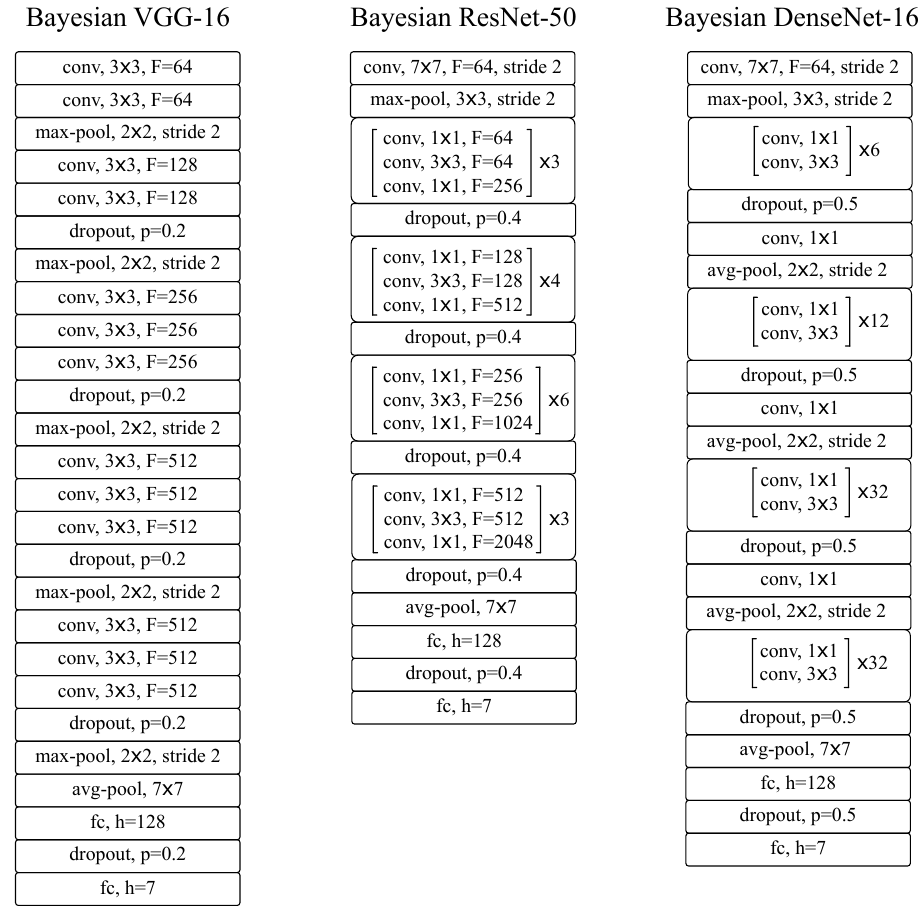
Figure A1. Designed Bayesian Network Architectures. In all convolution and pooling layers, stride is set to 1 unless otherwise mentioned. F represents the number of convolution filters and h is the number of units in the fully-connected